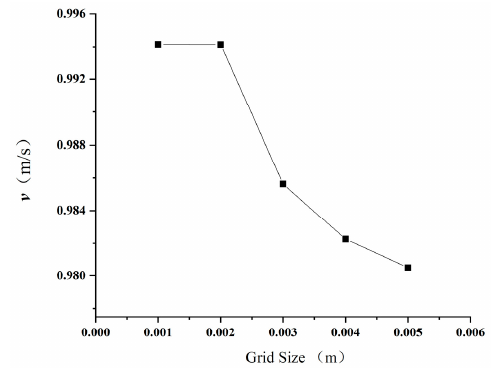
Figure 3. Schematic diagram of grid independence test. Note: v represents the average velocity of water flow at a distance of 0.2 m from the entrance of the pipeline.